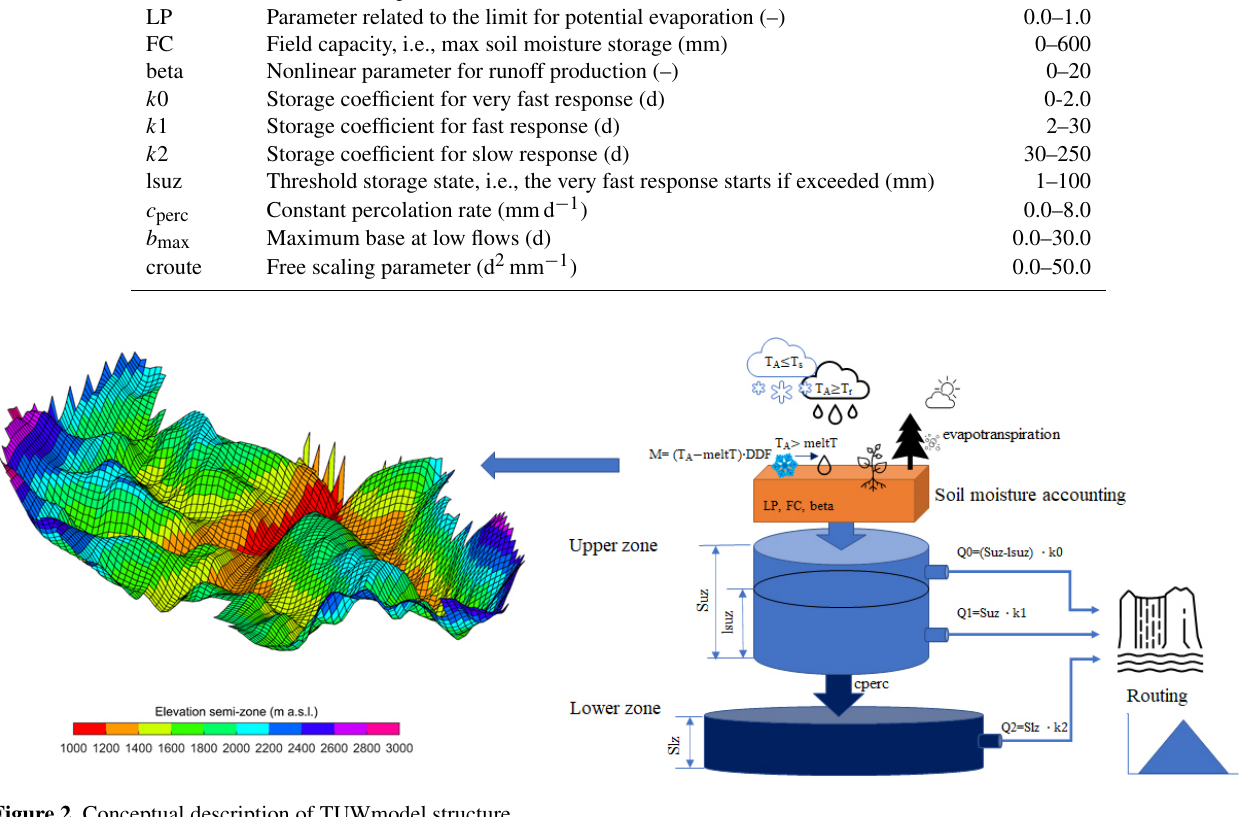
Figure 2. Conceptual description of TUWmodel